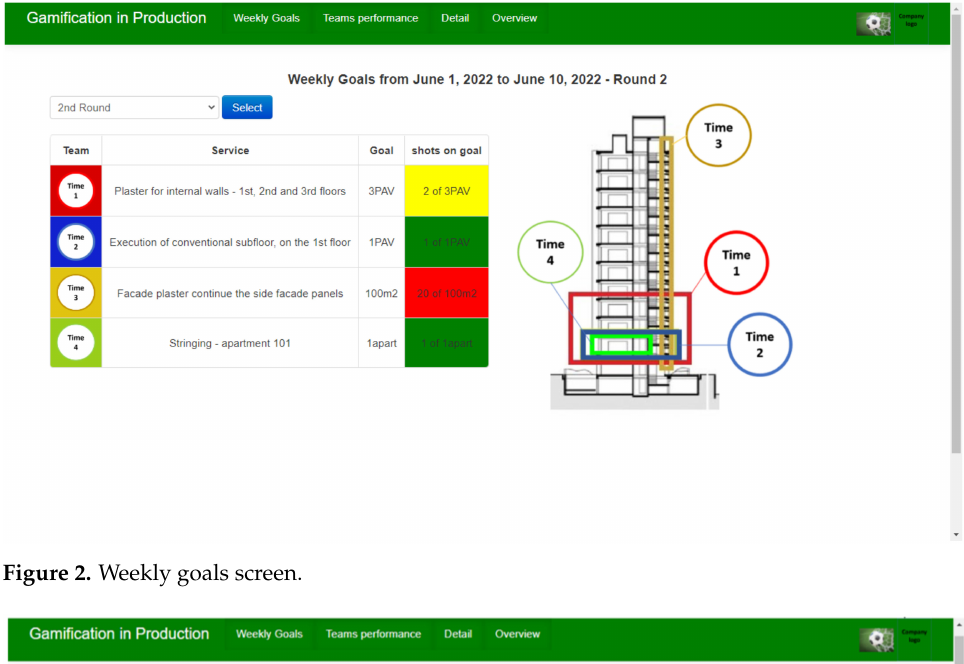
Figure 2. Weekly goals screen.